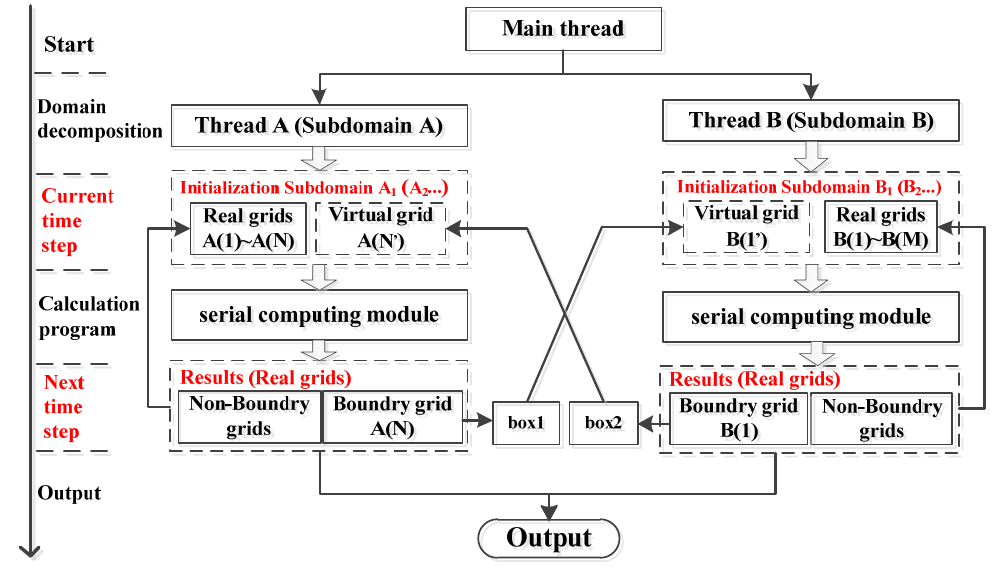
Figure 4. Solution steps of the non-hydrostatic model (parallel computing).